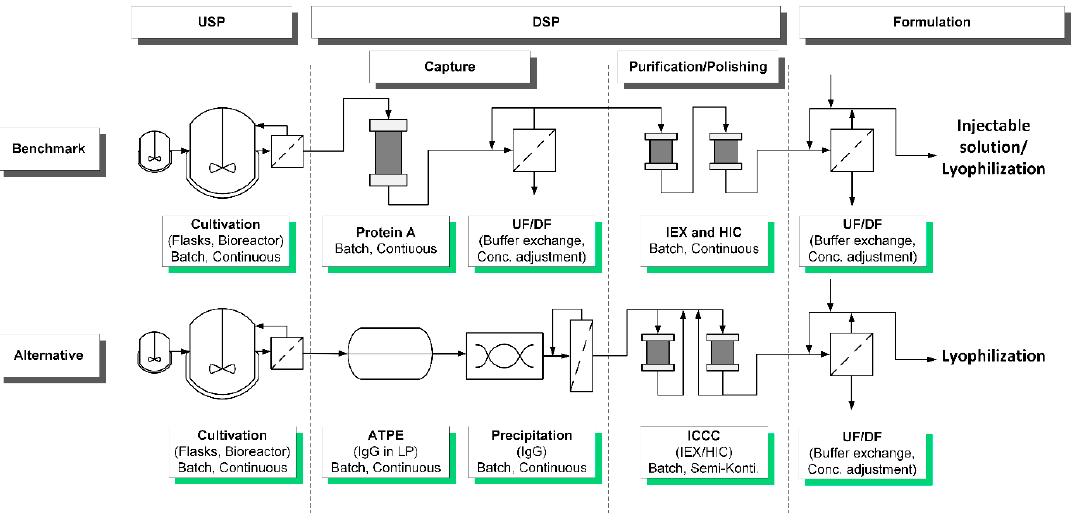
Figure 1. Current benchmark process for downstream processing (DSP) using the example of a purification of a monoclonal antibody (mAb) in comparison to an alternative process substituting protein A chromatography as captured through a combination of aqueous two-phase extraction (ATPE) and precipitation.